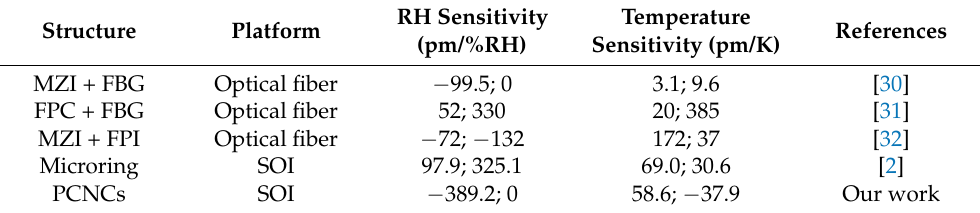
Table 1. The sensitivities of other structures on the basis of RH and temperature sensors.